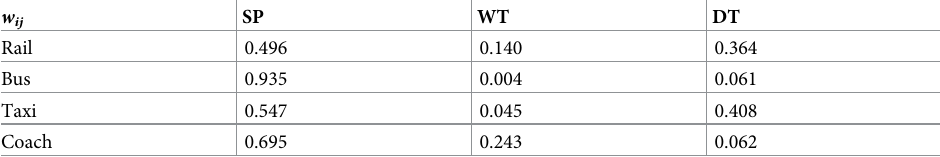
Table 10. Weight calculation results of the secondary indicators.